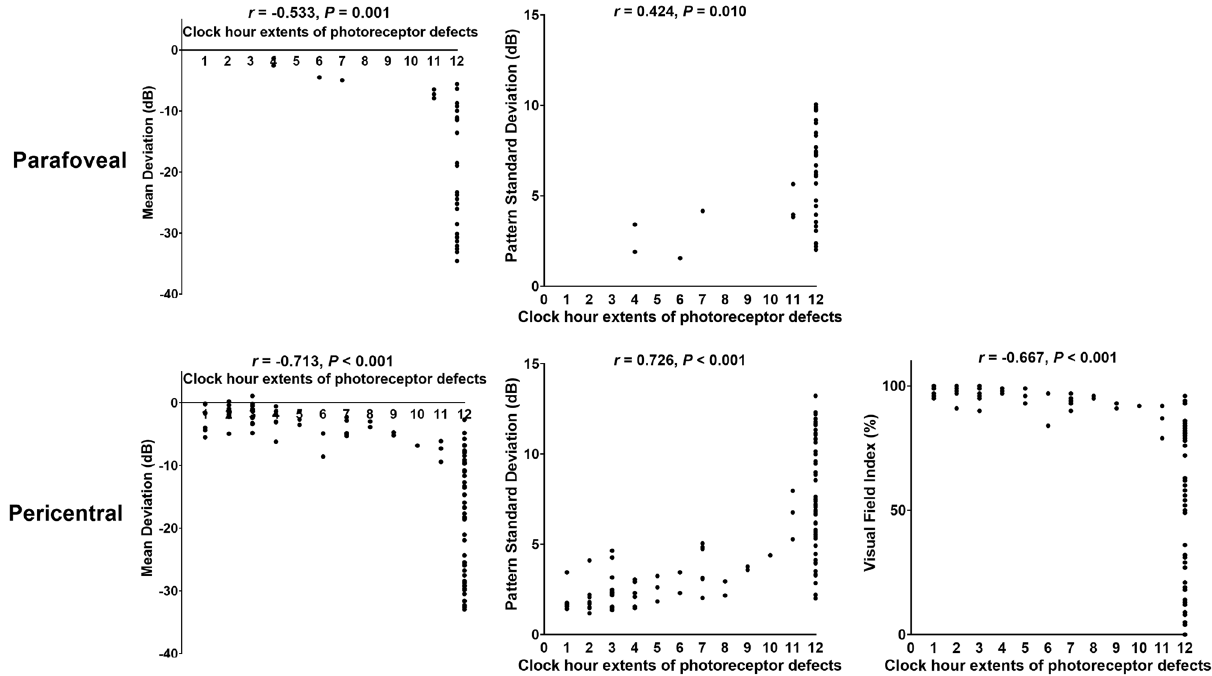
Figure 4. Correlation between clock-hour extents of parafoveal photoreceptor defects and mean deviation (MD) and pattern standard deviation (PSD) on the Humphrey 10–2 test (top) and that between those of pericentral photoreceptor defects and MD, PSD, and visual field index on the 30–2 test